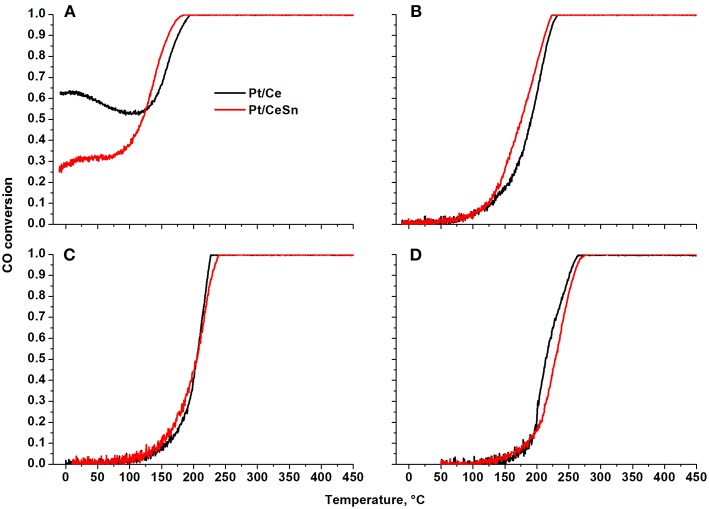
Temperature dependencies of CO conversion (TPR-CO+O2) for the Pt/Ce and Pt/CeSn catalysts calcined at different temperatures: (A) 600°C, (B) 700°C, (C) 800°C, and (D) 900°C.